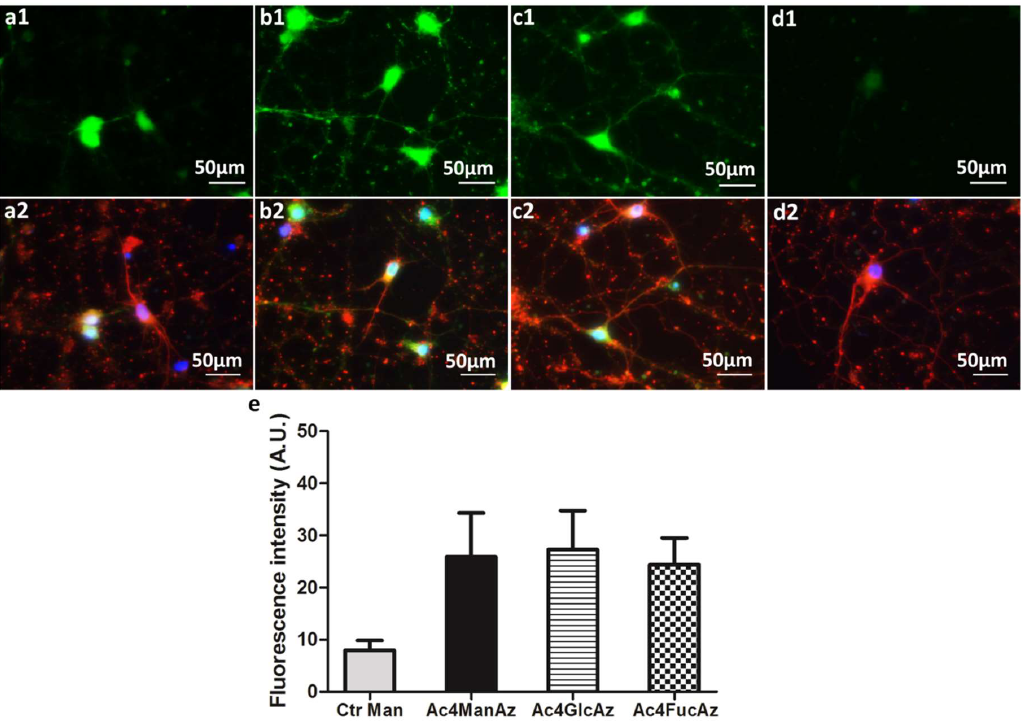
Figure 3. Hippocampal cells after 14 days in culture: ( a1 – c1 ) metabolic labelling of ( a1 ) Ac 4 ManAz, ( b1 ) Ac 4 GlcAz and ( c1 ) Ac 4 FucAz followed by DBCO-488/561 (50 µM); ( a2 – c2 ) immunostaining of βIII tubulin for the same cultures (red) and nuclei with DAPI (blue); ( d1 , 2 ) control samples supplemented with unmodified mannose and DBCO-488/561 (50 µM). ( e ) The graphic represents fluorescence intensity measured with Fiji software (v1.50e) using representative images for the different conditions.